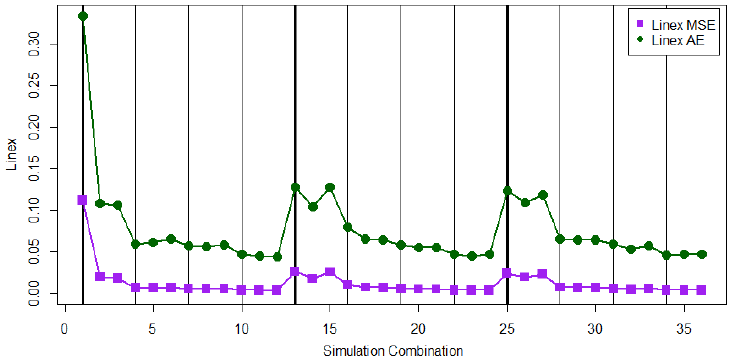
Figure 8. The values of EAE ( ˆ δ Linex ) and EAE ( ˆ δ Linex ) for the case of β 1 (cid:54) = β 2